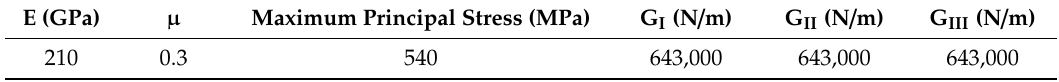
Table 4. Material properties of the hydraulic pipe.